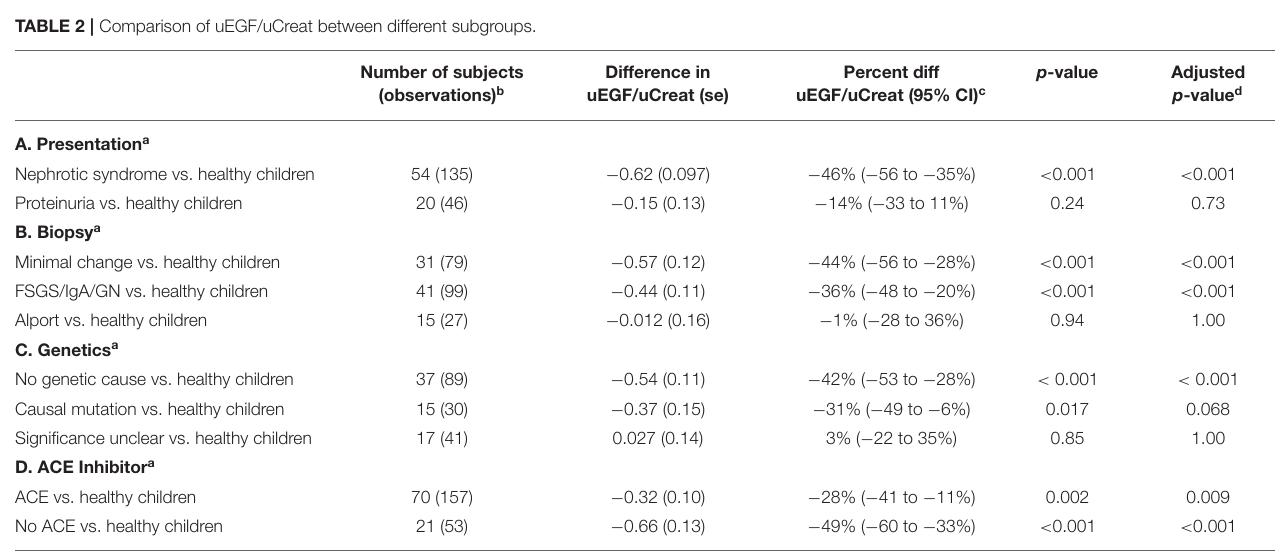
TABLE 2 | Comparison of uEGF/uCreat between different subgroups.